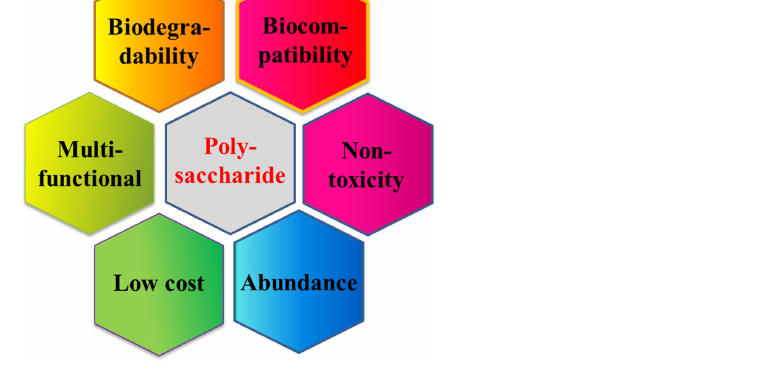
Figure 1. Advantages of natural polysaccharide based nano drug delivery